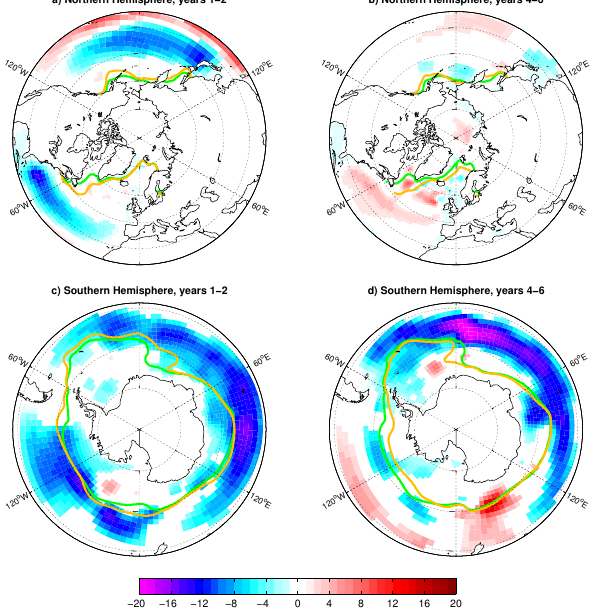
Figure 9. Ensemble-mean simulated annual-average oceanic barotropic stream function for integration years 1–2 (a, b) and 4–6 (c, d) of the SUPER1 ensemble. Only changes statistically signifi- cant at 95% confidence are shown. The green and orange lines indi- cate, respectively, the pre-eruption and post-eruption average winter (top: DJF; bottom: JJA) sea-ice edge.